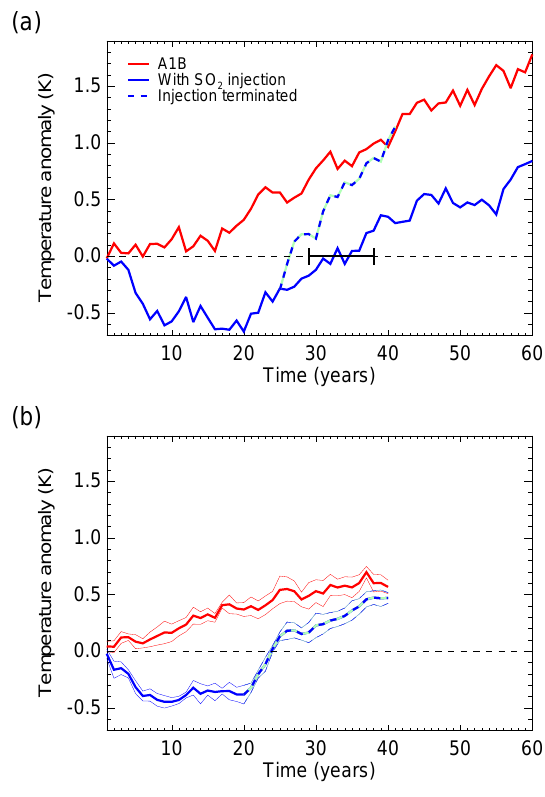
Fig. 3. (a) Evolution of annual global-mean near-surface air temperature anomaly (K) in HadGEM2 with respect to the 1990–1999 mean in a historical simulation. The red line is for the A1B scenario, solid blue line A1B plus geoengineering, and dashed blue line after geoengineering has been terminated. The 10-year period over which the mean near-surface air temperature anomaly is zero is marked. (b) As (a) but for ModelE, with the anomaly being with respect to the constant-1999 control. The thin lines indicate ± one standard deviation of the difference between the annual means of the ModelE ensemble